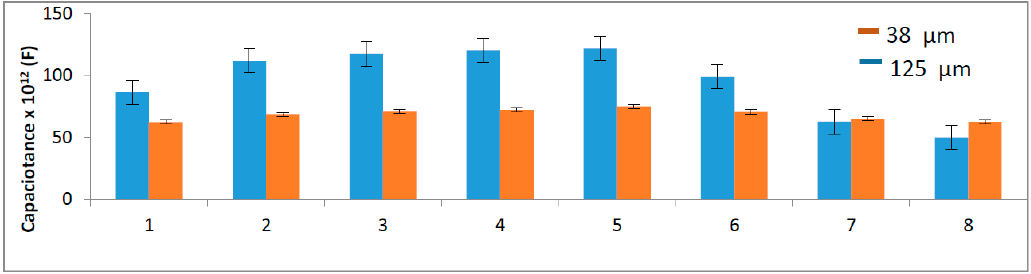
Figure 6. Use of a gelatin sensor for monitoring the heating processing in meat cooking: 90% RH, 125 µm (600 MHz) and 38 µm (868 MHz). Bars are: 1: 40 °C for 30 min; 2: 65 °C for 90 min; 3: 70 °C for 60 min; 4: 75 °C for 60 min; 5: 80 °C for 60 min; 6: 80–55 °C for 90 min; 7: 55–27 °C for 120 min; 8: 27–3 °C for 120 min. Error bar: standard deviation; sample size = 3.